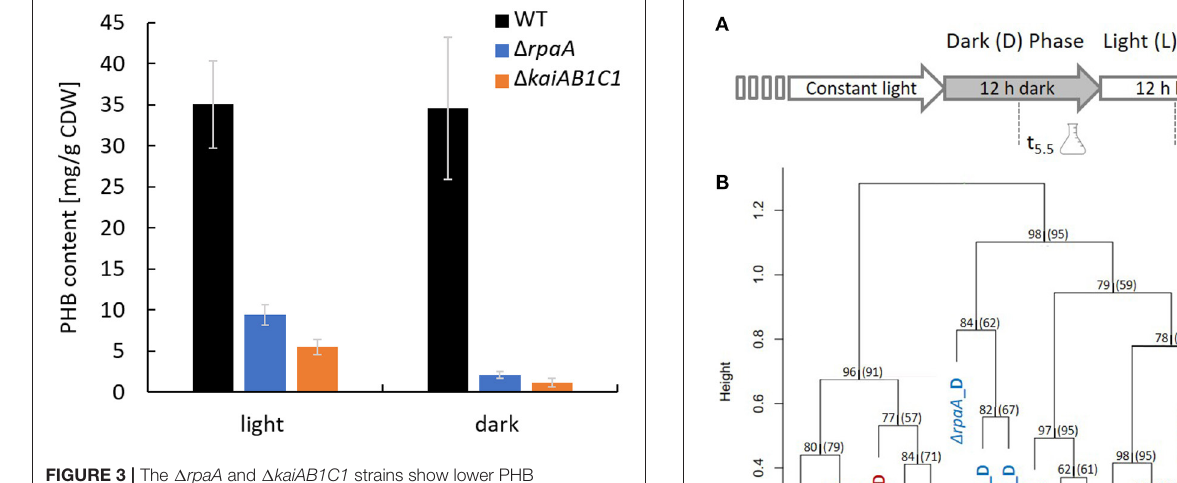
FIGURE 3 | The 1 rpaA and 1 kaiAB1C1 strains show lower PHB accumulation at high CO 2 concentrations. PHB was quantified in cells cultivated in a 12-h L/12-h D cycle and 1% CO 2 . The samples used for the PHB measurements were collected in the stationary phase at an OD 750 of ∼ 7 in the L and D phases of the 7th L/D cycle 1h before switching. Each bar displays the mean of three technical replicates ( ± standard deviation).